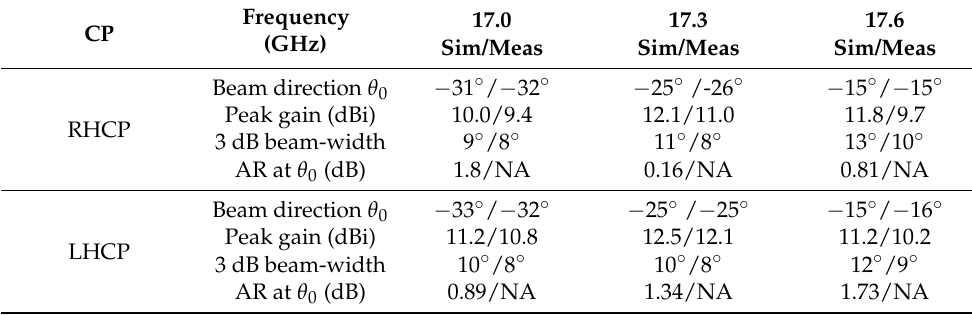
Table 1. Measured and simulated results of CP.